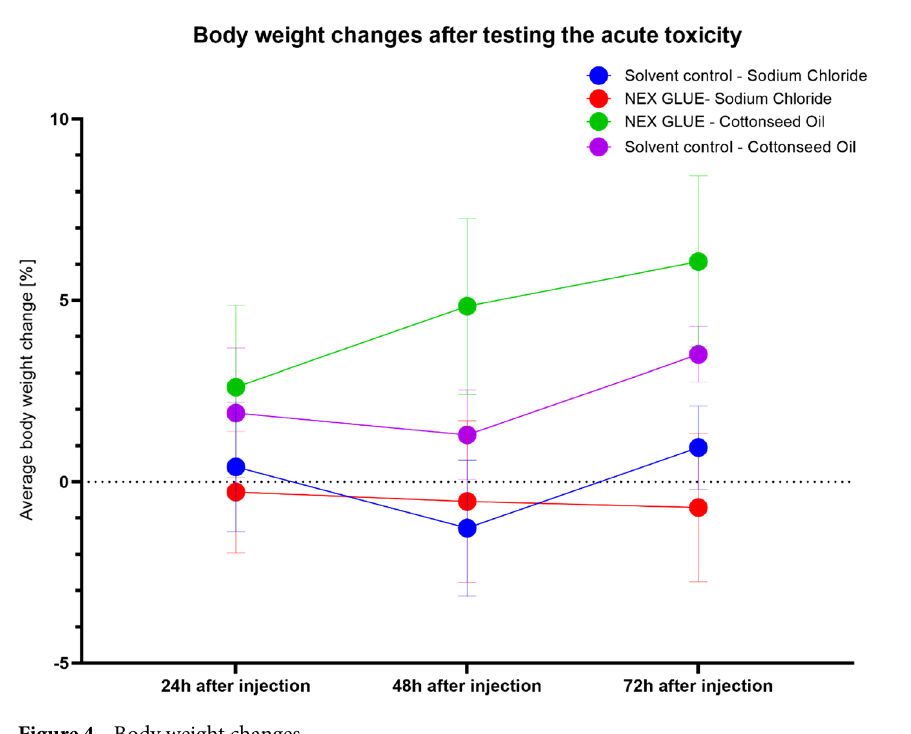
Figure 4. Body weight